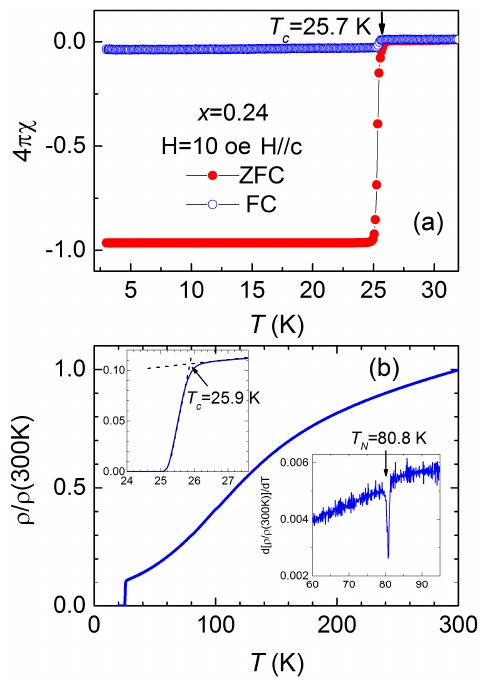
Figure 1. ( a ) Temperature dependence of magnetization for the (Ba 1 − x K x )Fe 2 As 2 single crystal ( x = 0.24) used in resistivity and polarized optics studies. The sample was cooled in zero magnetic field from above T c to 3 K (ZFC) and with an applied field of 10 Oe (FC). The data were collected during the warming of the sample from 3 K to 35 K; ( b ) Normalized temperature-dependent resistivity of a sample, cut from part of magnetization crystal after polarized optics study. The derivate of the normalized resistivity (inset in panel b) shows a clear dip as the sample undergoes structure and magnetic transition at T N = 80.8